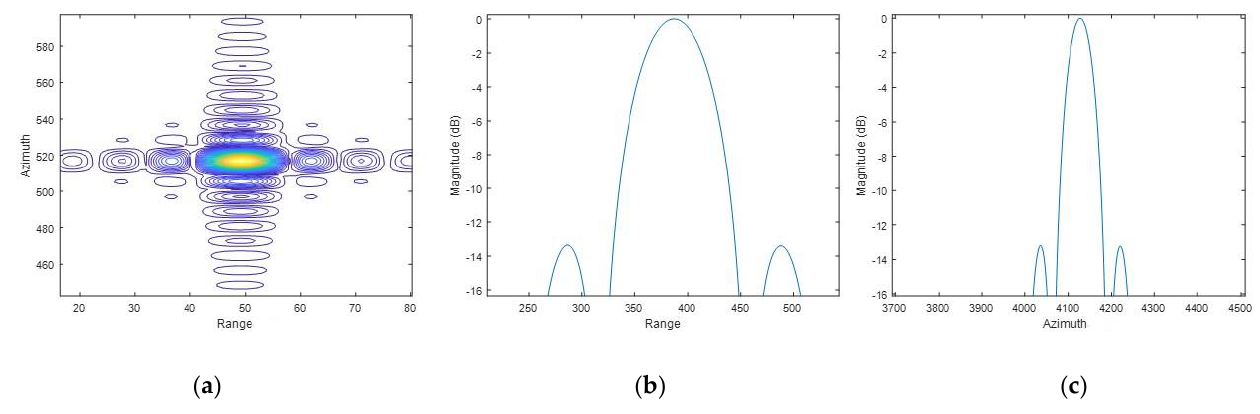
Figure 11. Refocused result of the moving target T4. ( a ) Impulse responses of T4. ( b ) Range profile of T4. ( c ) Azimuth profile of T4.